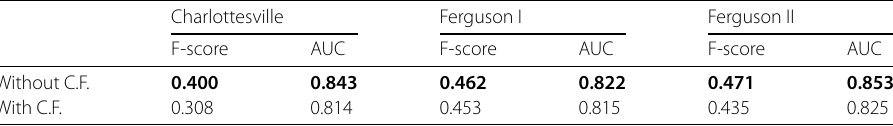
Table 4 Forecasting results with and without hashtag features. C.F. stands for content features Charlottesville Ferguson I Ferguson II F-score AUC F-score AUC F-score AUC Without C.F.